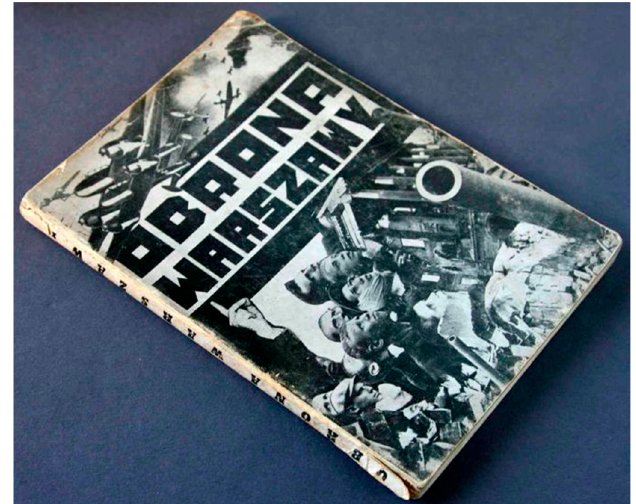
Figure 1. Obrona Warszawy . Lud Polski w Obronie Stolicy (Wrzesie ń 1939 roku) [ The Defense of Warsaw